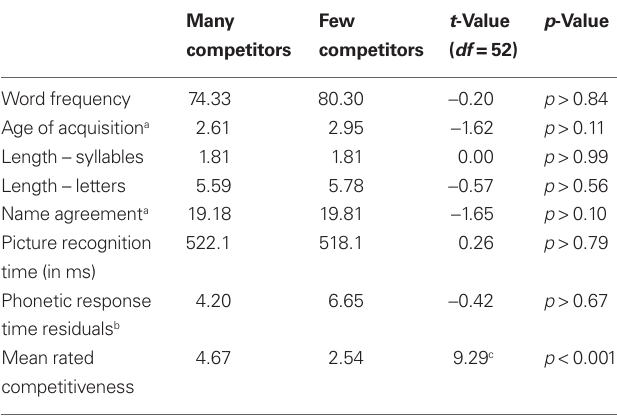
Table 1 | Features of target words with many and few